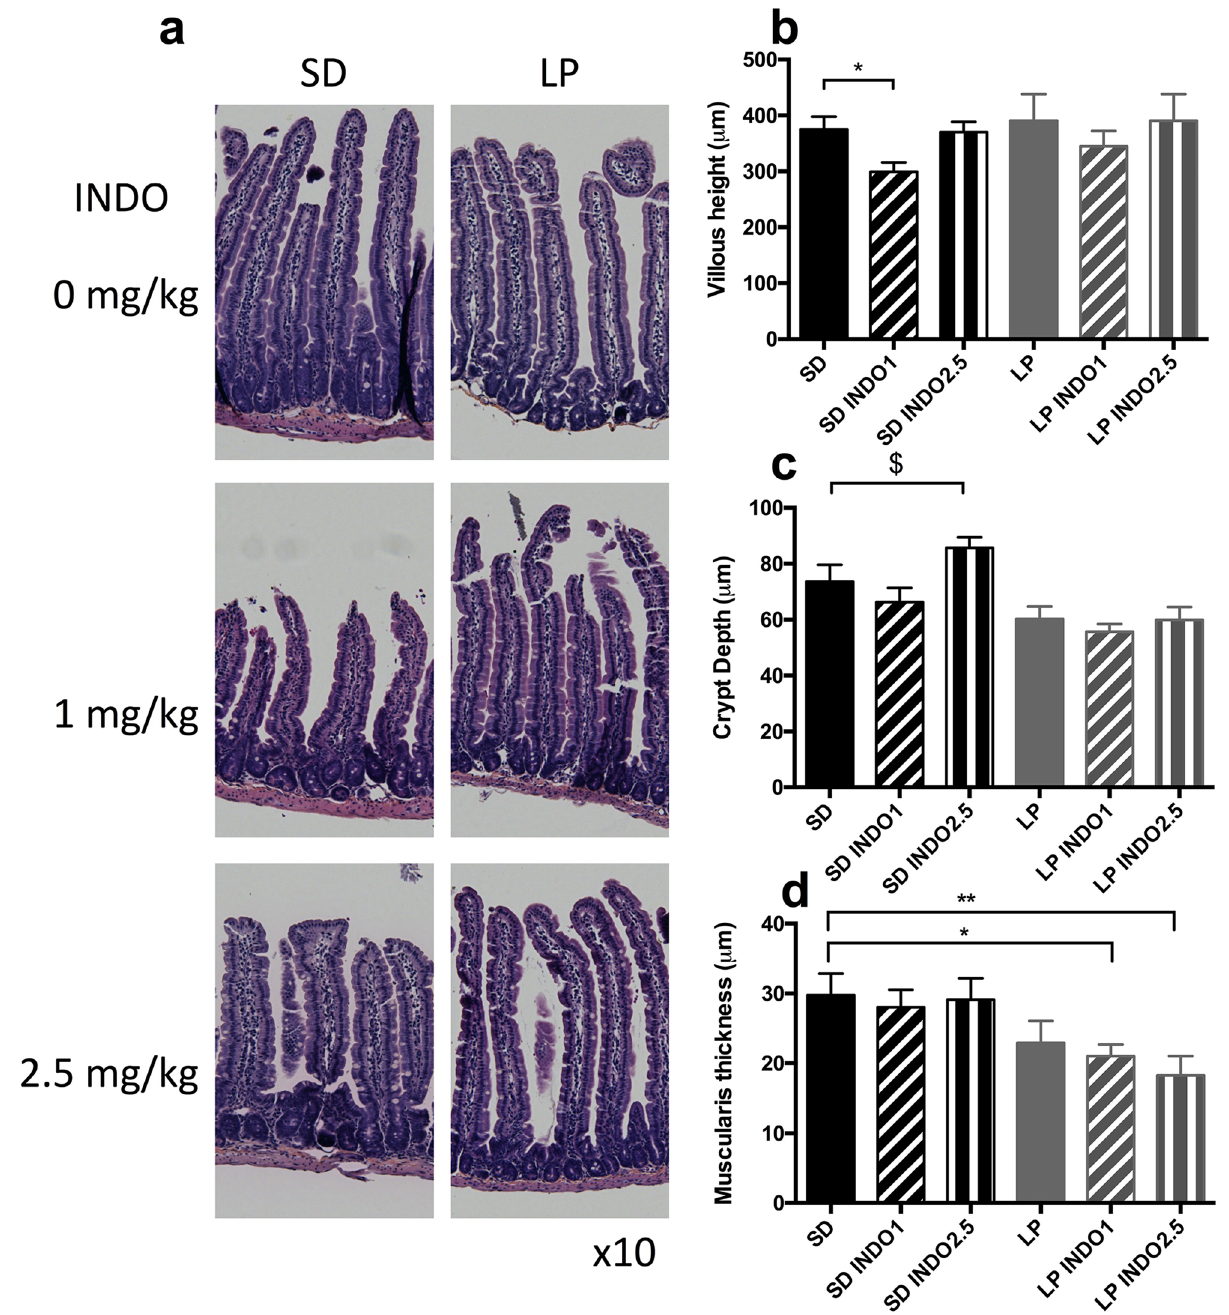
Figure 6. Villi length, crypt depth and muscularis thickness in C57BL/6 mice fed a low protein or isocaloric standard diet combined with chronic indomethacin gavages. ( a ) Jejunal section stained with HES solution were used to assess Intestinal damages. ( b ) Villi length (t test *P = 0.0186 vs. SD), ( c ) crypt depth (Mann–Whitney $ P = 0.0714 vs. SD) and ( d ) muscularis thickness (t test *P = 0.0254 vs. SD − Mann–Whitney **P = 0.0283 vs. SD) were measured. Unpaired t-test or Mann–Whitney test was performed SD, Standard diet; SD INDO 1 Standard Diet + indomethacin gavages (1 mg/kg); SD INDO 2.5 Standard Diet + indomethacin gavages (2.5 mg/kg); LP, Low protein diet; LP INDO 1 LP + indomethacin gavages (1 mg/kg); LP INDO 2.5 LP + indomethacin gavages (2.5